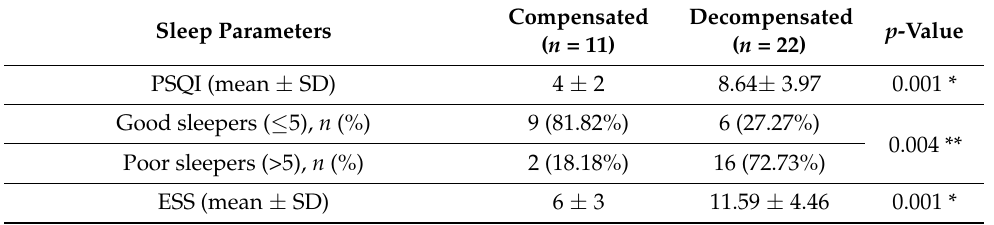
Table 3. Comparison between compensated and decompensated cirrhosis regarding sleep